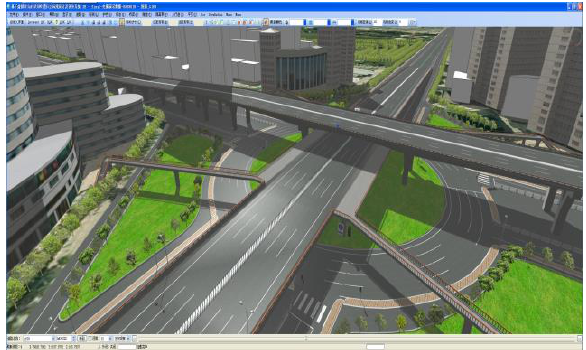
Figure 1 3D road network generation effect diagram based on GRID